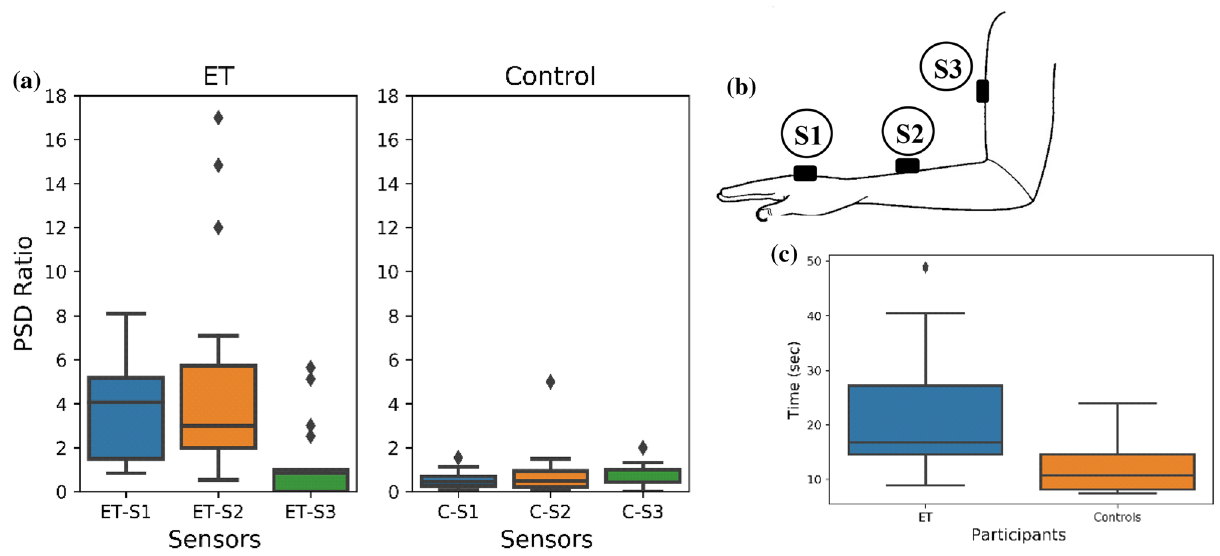
Figure 1. a Boxplot of the PSD ratio for ET and controls at the three sensing locations. ETS1—ET Sensor—1, ETS2—ET Sensor—2, ETS3—ET Sensor—3; and for Controls, CS1—Control Sensor—1, CS2—Control